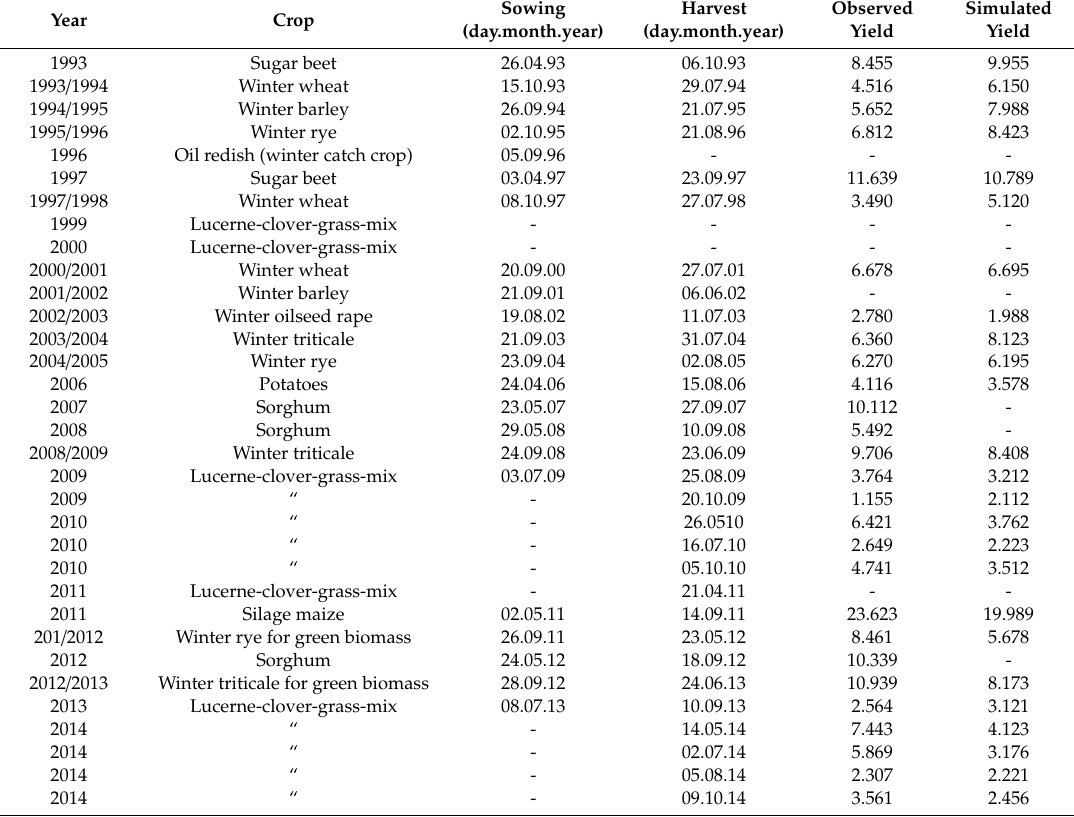
Sowing Harvest Observed Simulated (day.month.year) (day.month.year) Yield Yield